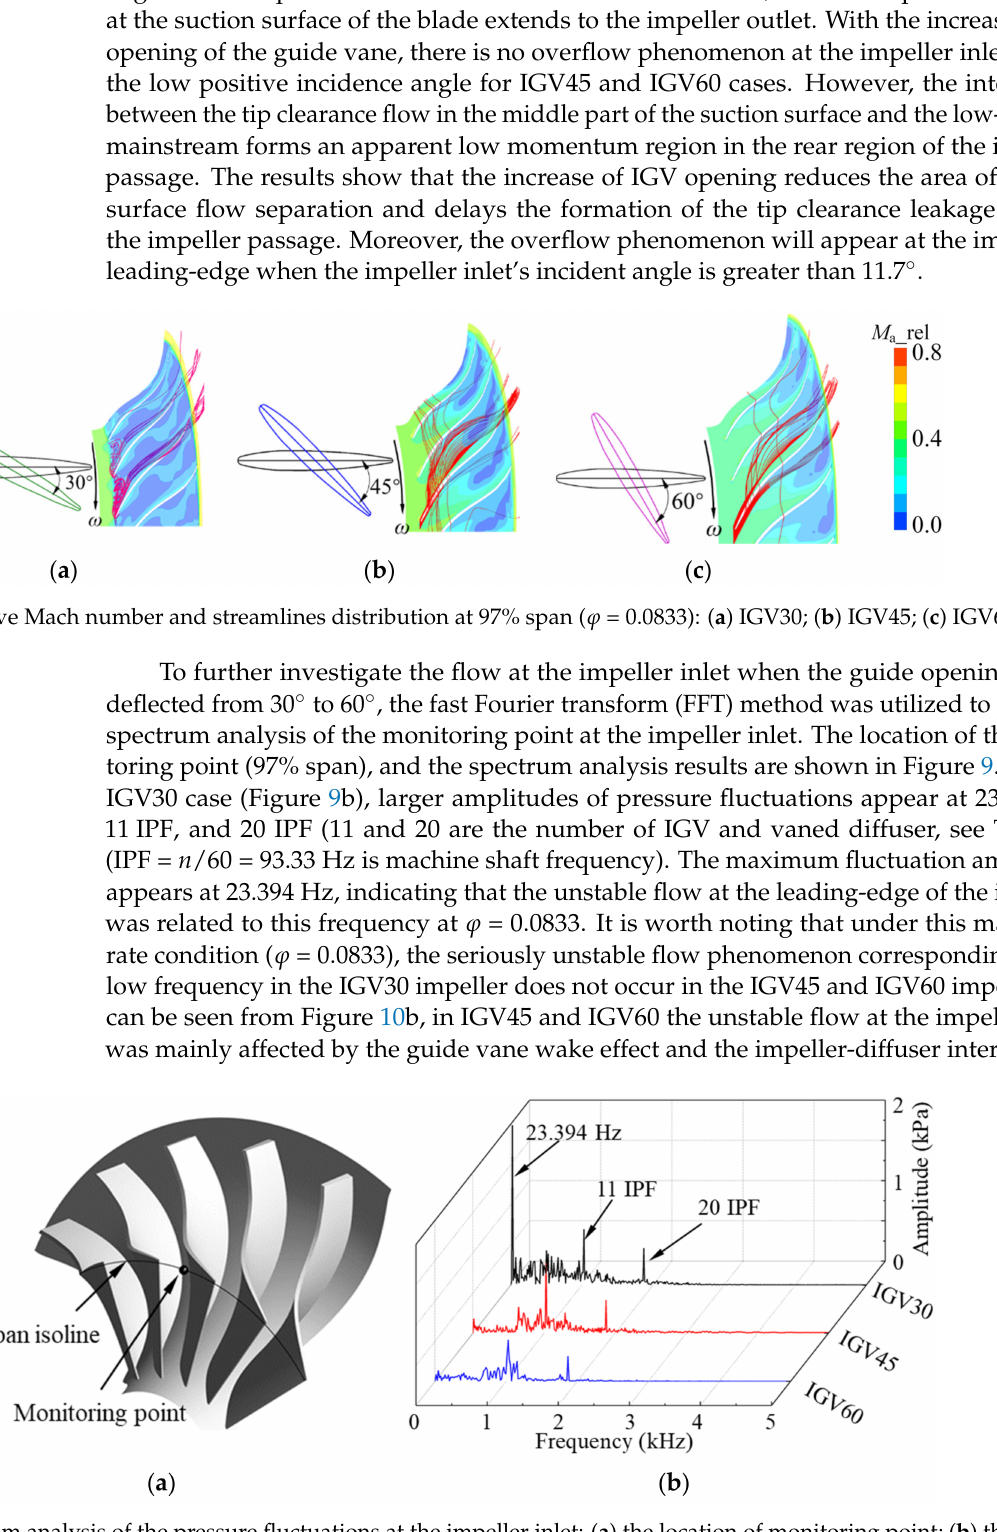
Figure 9. Spectrum analysis of the pressure fluctuations at the impeller inlet: ( a ) the location of monitoring point; ( b ) three types of guide vane openings ( ϕ =